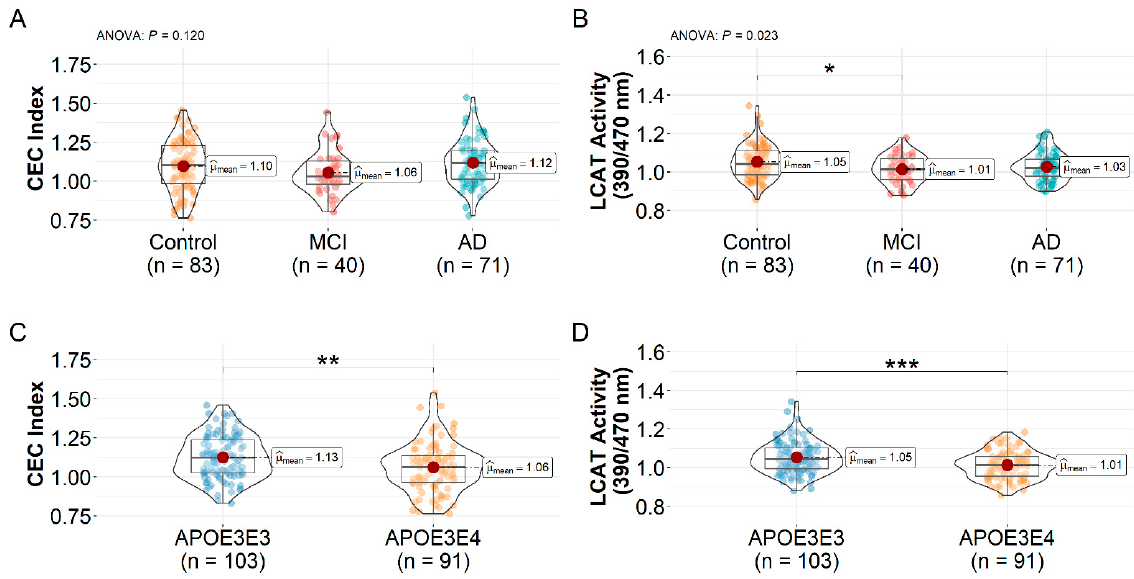
Figure 1. APOE3E4 carriers have reduced HDL CEC index and LCAT activity. HDL ( A ) CEC index